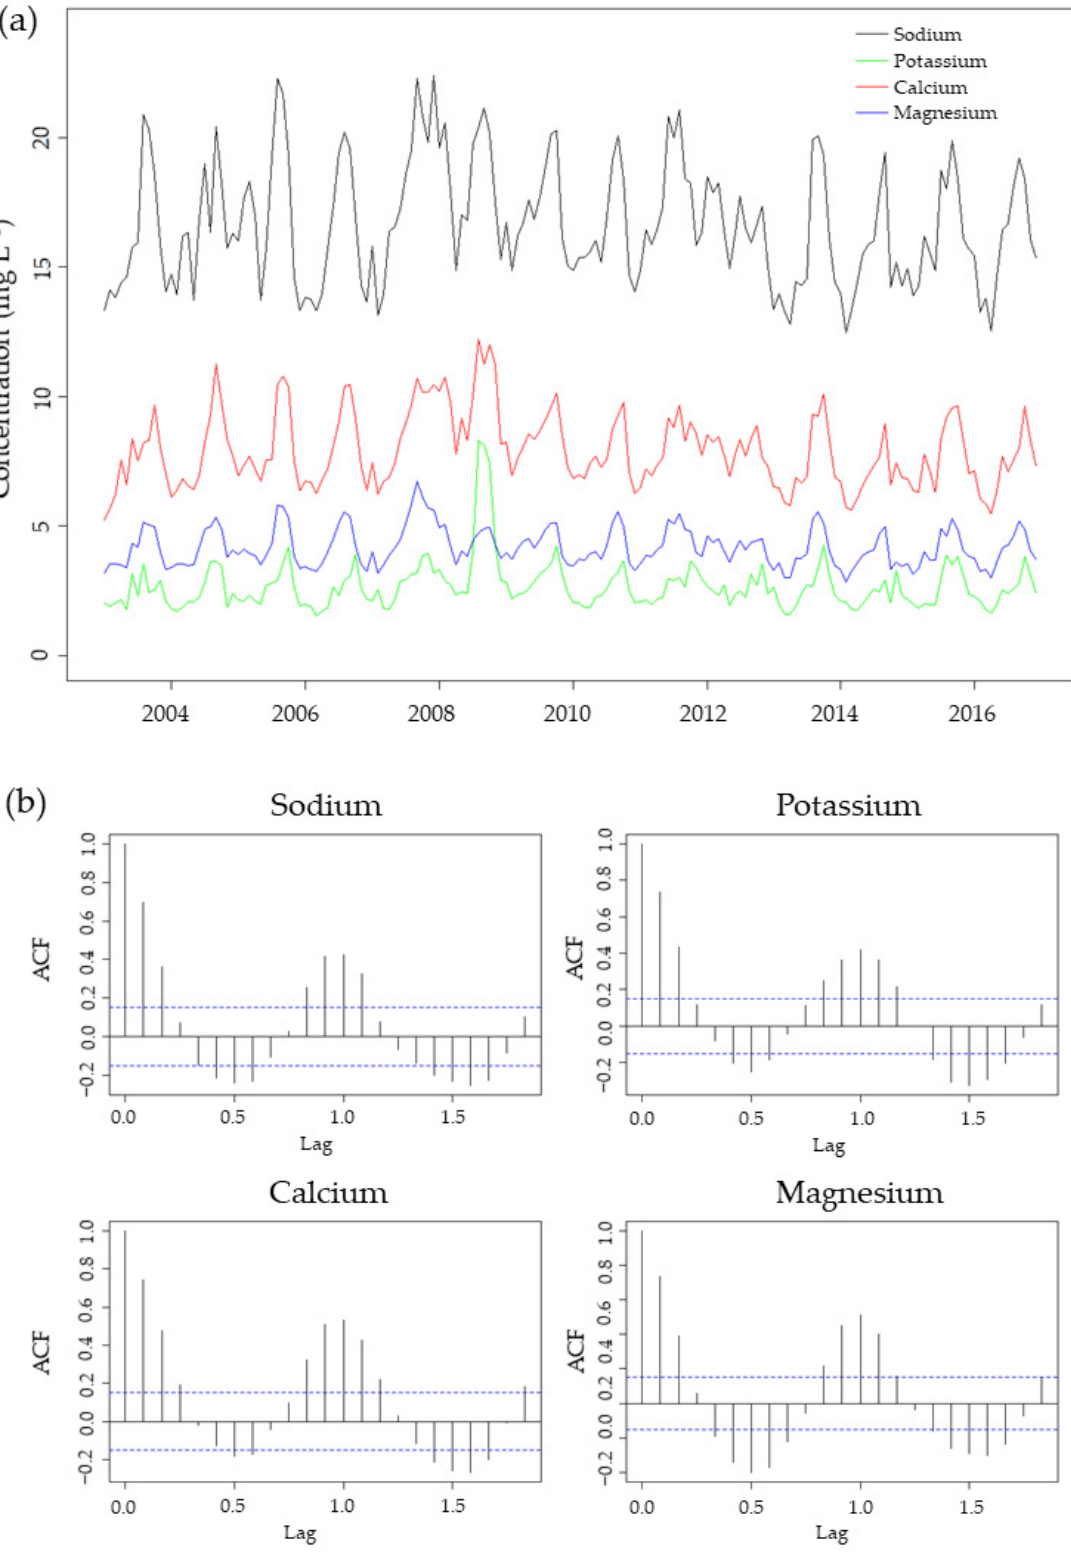
Figure 5. Temporal evolution ( a ) of the monthly concentration of sodium, potassium, calcium, and magnesium in water samples of the Valiñas catchment. Autocorrelation functions (ACF) for the four studied macronutrients ( b ).